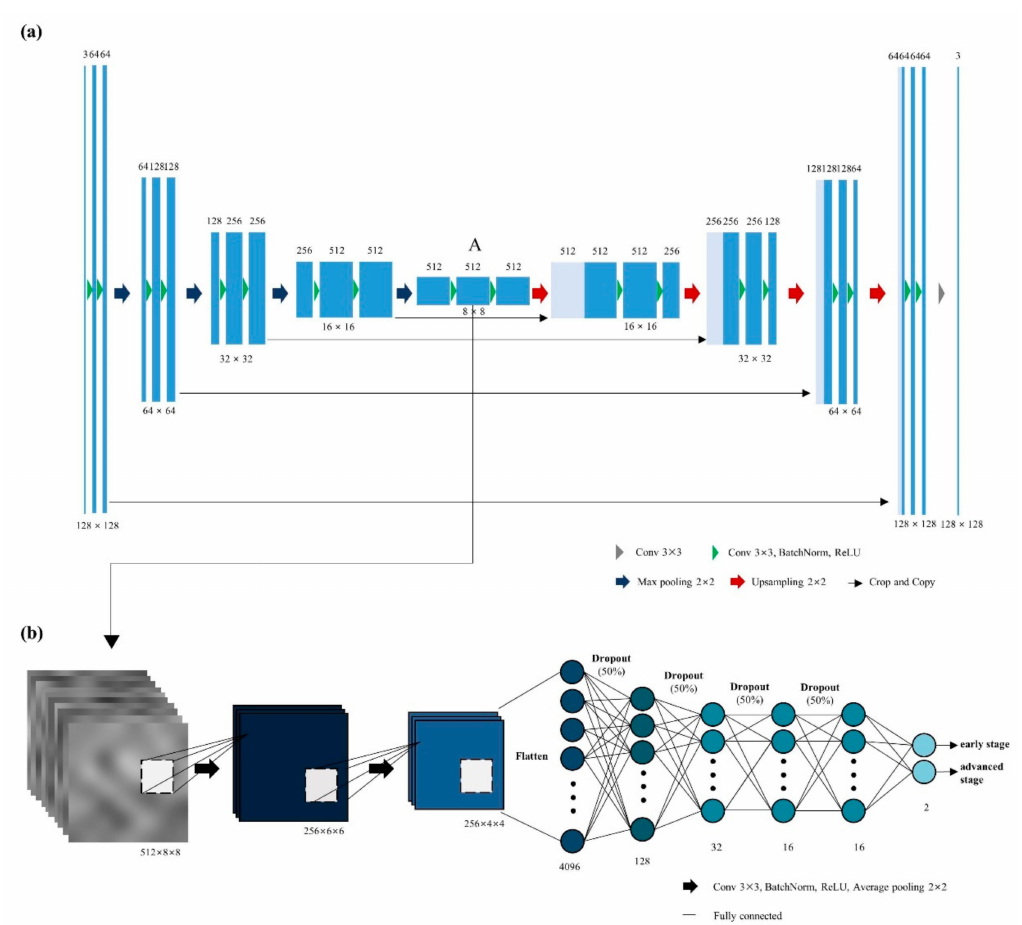
Figure 2. Model architectures. ( a ) U-net autoencoder for reconstructing CT images. ( b ) Classification networks for classifying early- and advanced-stage utilizing latent variable (noted with A) from ( a ) as